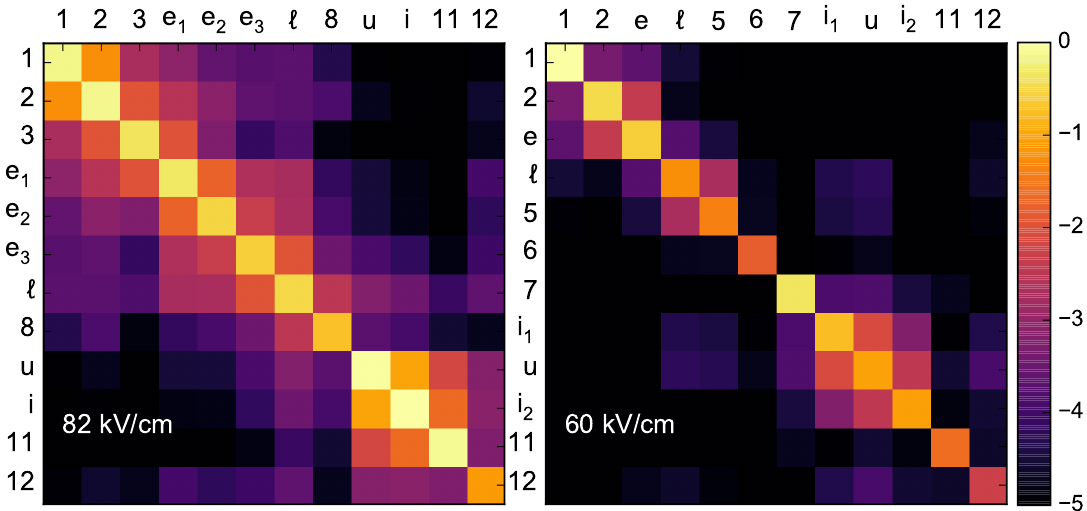
( | ρ | ) for a lattice temperature of 298 K. Normalization is chosen Figure 7. A color map showing log ij 10 such that the largest matrix element is 1. The left panel shows results around lasing (82 kV/cm) for all the states shown in the band structure in Figure 1d. Important states are labeled, while other states are given numbers in increasing order of energy. The right panel shows the same quantity, but for a field below lasing (60 kV/cm). The corresponding band structure is not shown; however, important states are given